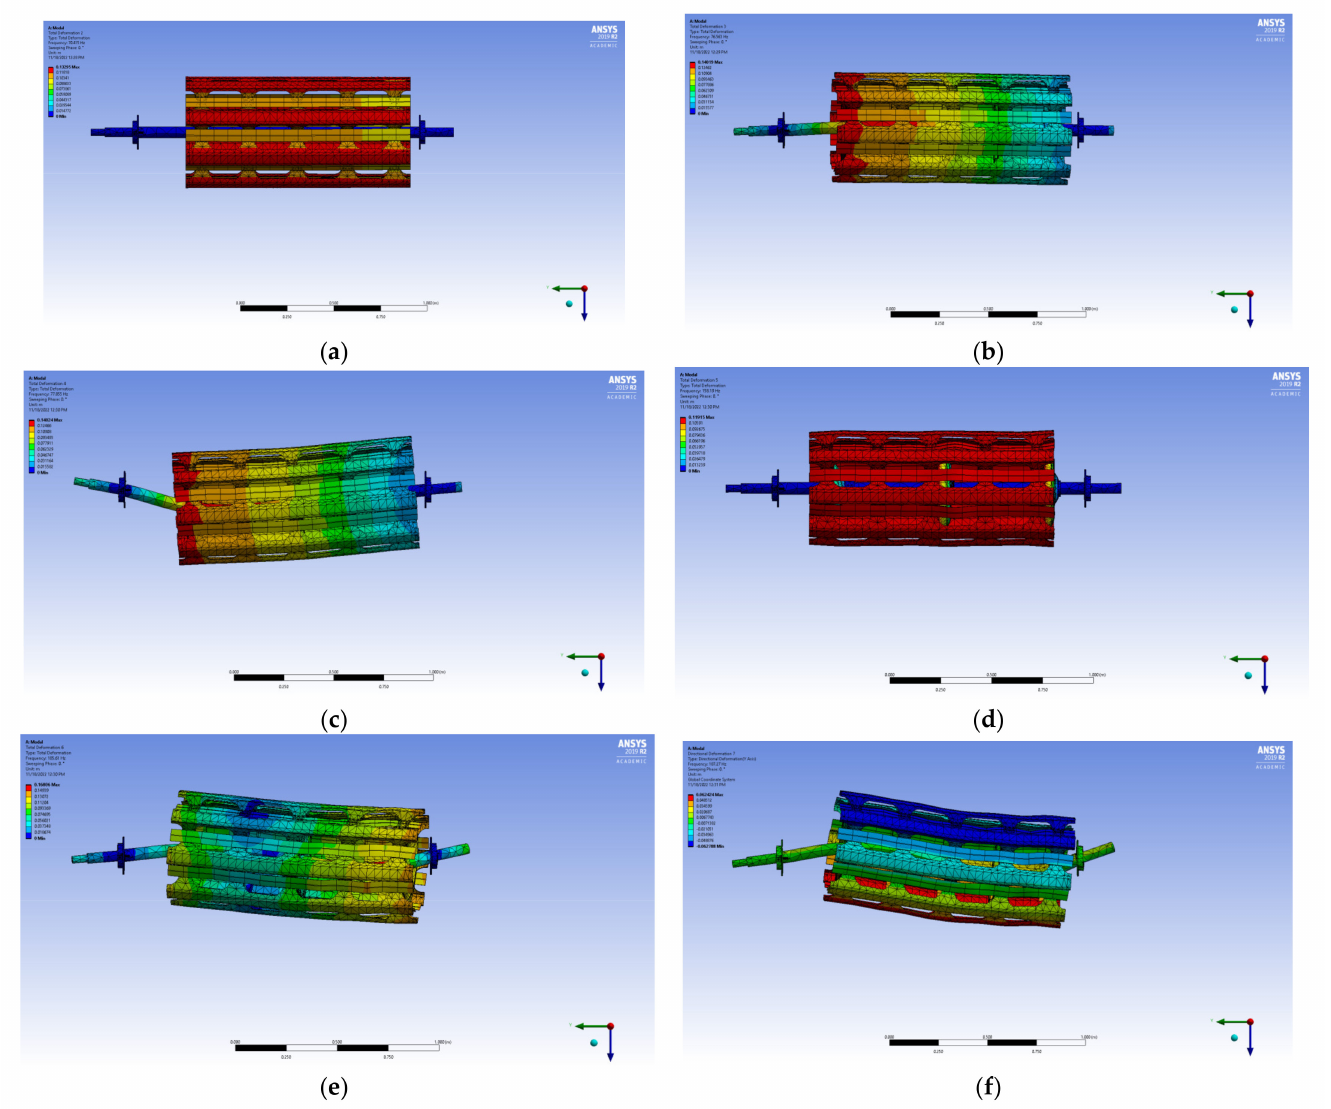
Figure 7. Modal analysis of the threshing cylinder. ( a ) First-order modal shape (70.41 Hz); ( b ) Second- order modal shape (76.56 Hz); ( c ) Third-order modal shape (77.85 Hz); ( d ) Fourth-order modal shape (158.9 Hz); ( e ) Fifth-order modal shape (185.61 Hz); and ( f ) Sixth-order modal shape (187.27